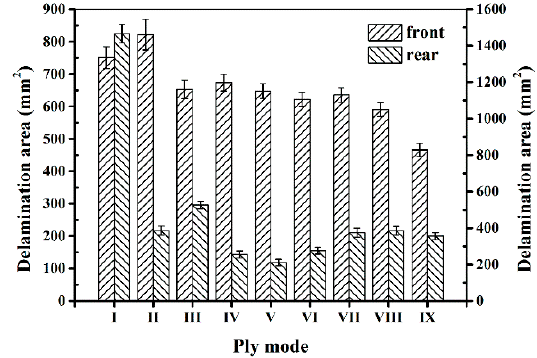
Figure 5. Delamination areas in the front and rear face-sheets of different sandwich panels.